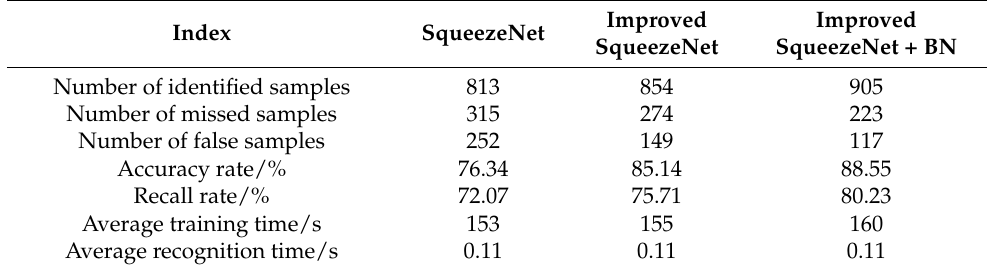
Table 3. Relief hole target recognition results based on different SqueezeNet models.